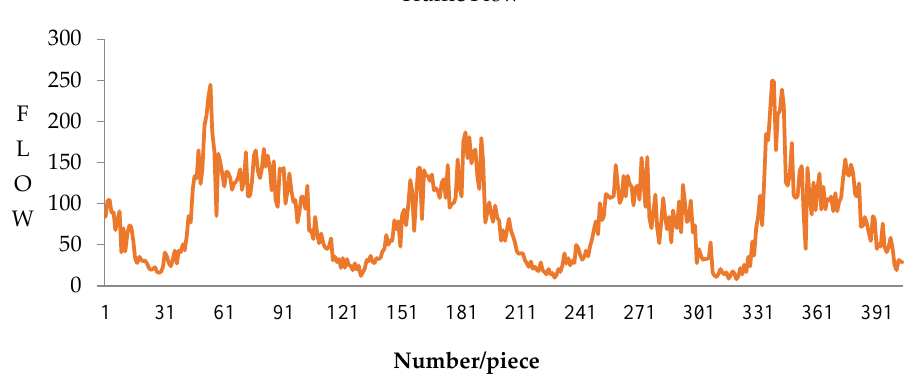
Figure 8. The traffic flow trend.